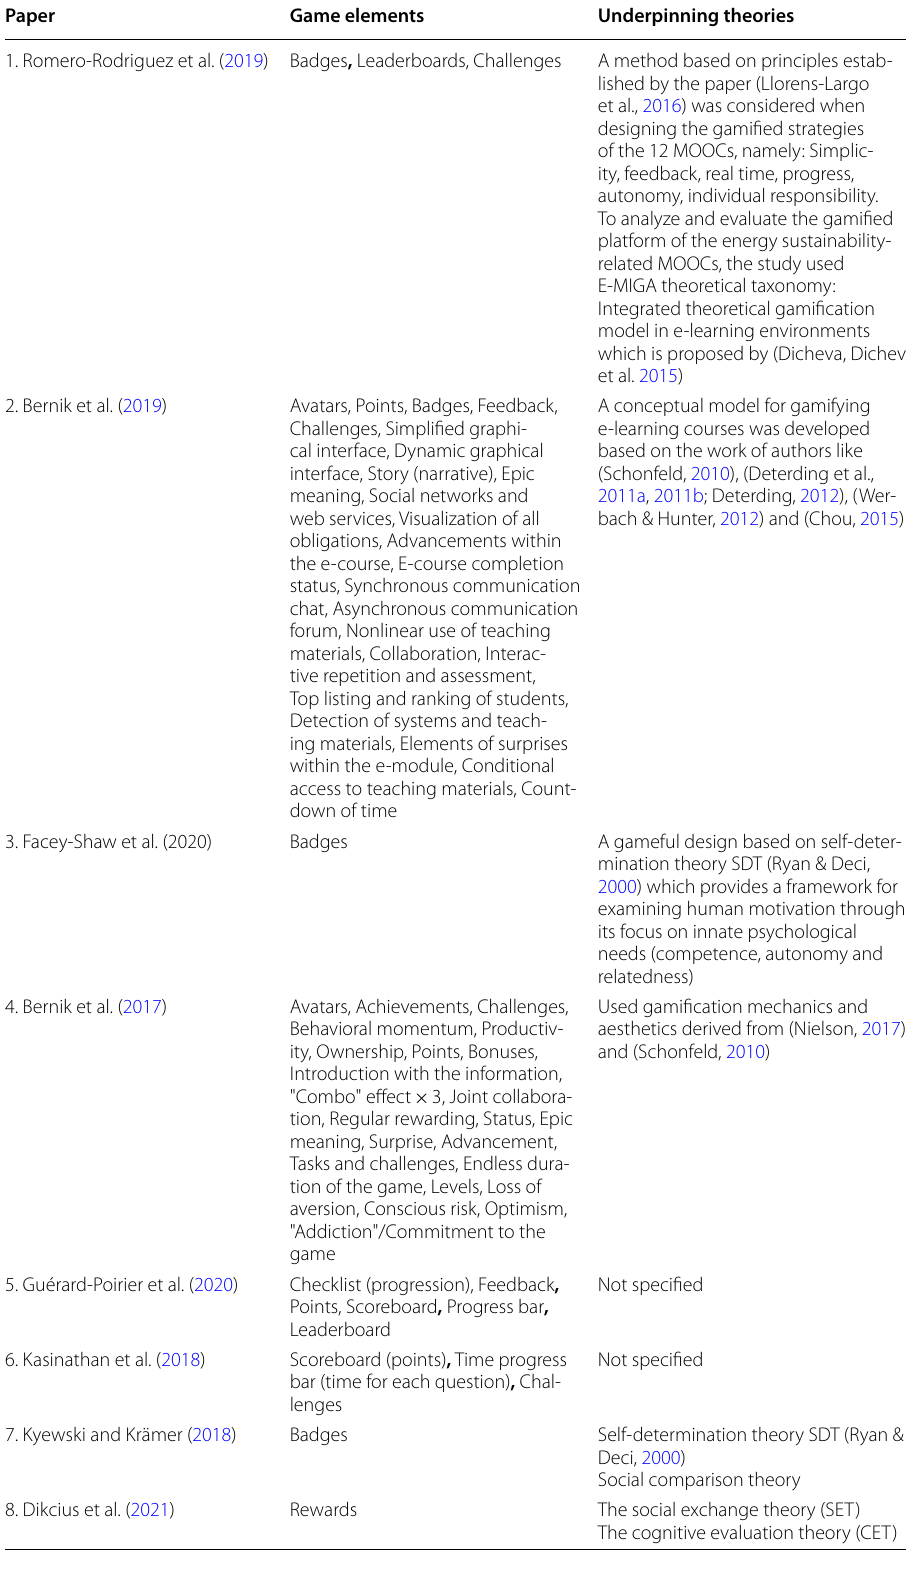
Table 2 Experimental studies on gamification of e-learning in higher education